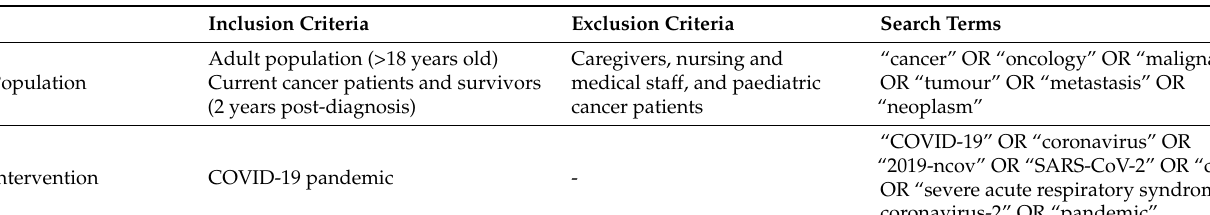
Table 1. Inclusion criteria and search